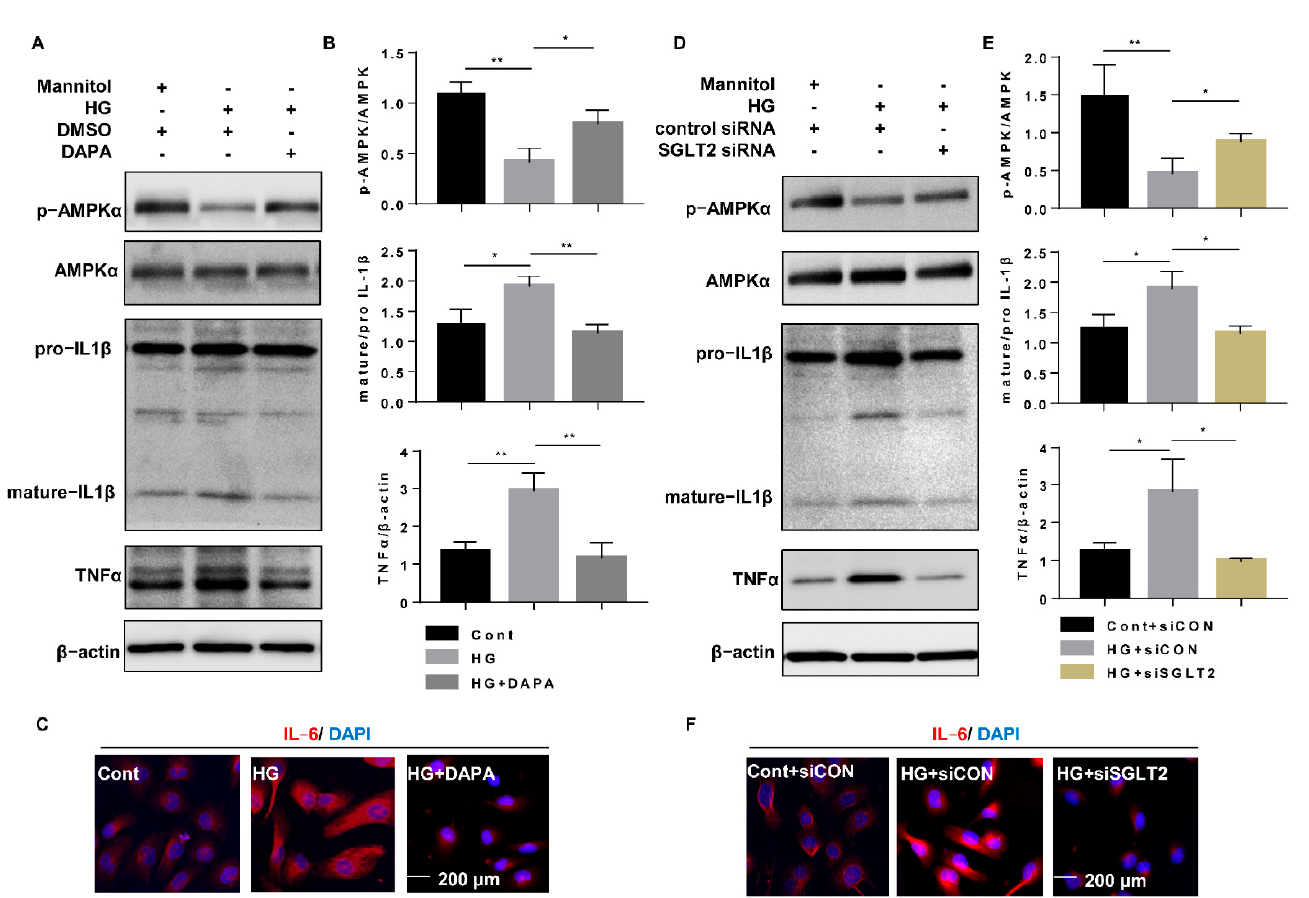
Figure 4. SGLT2 inhibition suppressed HG-induced inflammatory alterations. ( A ) HK-2 cells were incubated with Cont, HG (30 mM), or HG (30 mM) dapagliflozin (20 µ M) for 48 h, and p-AMPK, AMPK, IL-1 β , and TNF α were assessed by western blotting. ( B ) Densitometric evaluation of ( A ) (n = 3). ( C ) Immunofluorescence of IL-6 in HK-2 cells cultured with Cont, HG (30 mM), or HG (30 mM) dapagliflozin (20 µ M) for 48 h. ( D ) HK-2 cells were transfected with SGLT2 siRNA (200 nM) or control siRNA for 6 h and then incubated with Cont or HG (30 mM) medium for 48 h. P-AMPK, AMPK, IL-1 β , and TNF α were assessed by western blotting. ( E ) Densitometric evaluation of ( D ) (n = 3). ( F ) Immunofluorescence of IL-6 in HK-2 cells transfected with SGLT2 siRNA (200 nM) or control siRNA for 6 h and then treated with Cont or HG (30 mM) medium for 48 h. All data represent the mean ± standard deviation (SD). * p < 0.05 vs. the indicated group, ** p < 0.01 vs. the indicated group (n = 3). Cont, control; HG, high glucose; DAPA, dapagliflozin; siCON, control siRNA; siSGLT2; and SGLT2 siRNA.